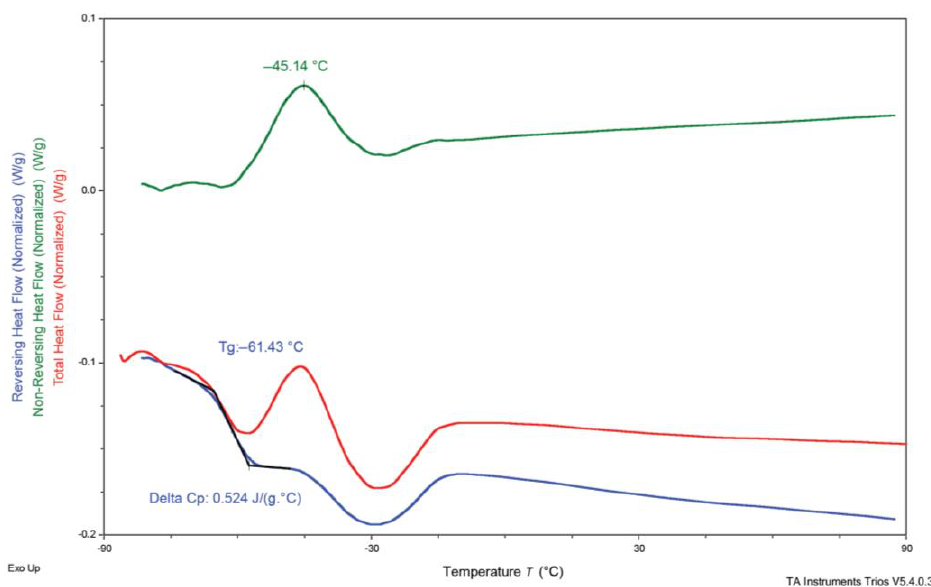
Figure 7. DSC thermogram of the decrosslinked material.